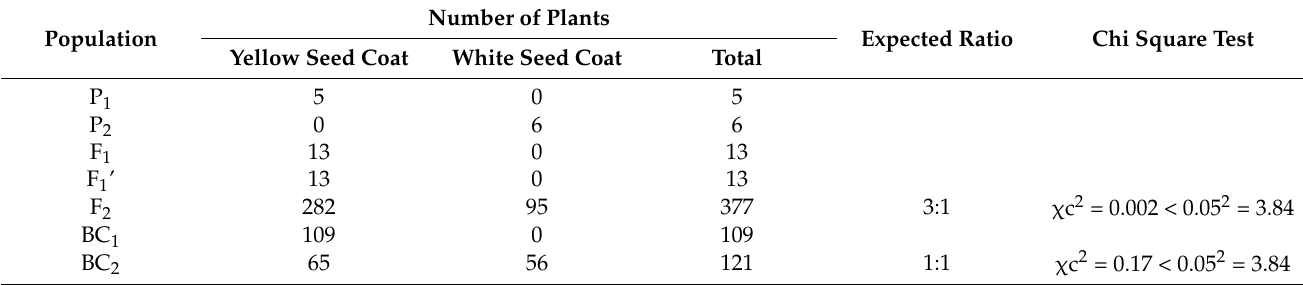
Table 2. The segregation proportion of yellow seed coat and white seed coat in P 1 , P 2 , F 1 , F 1 (cid:48) , F 2 , BC 1 , and BC 2 . Number of Plants Population Expected Ratio Chi Square Test Yellow Seed Coat White Seed Coat